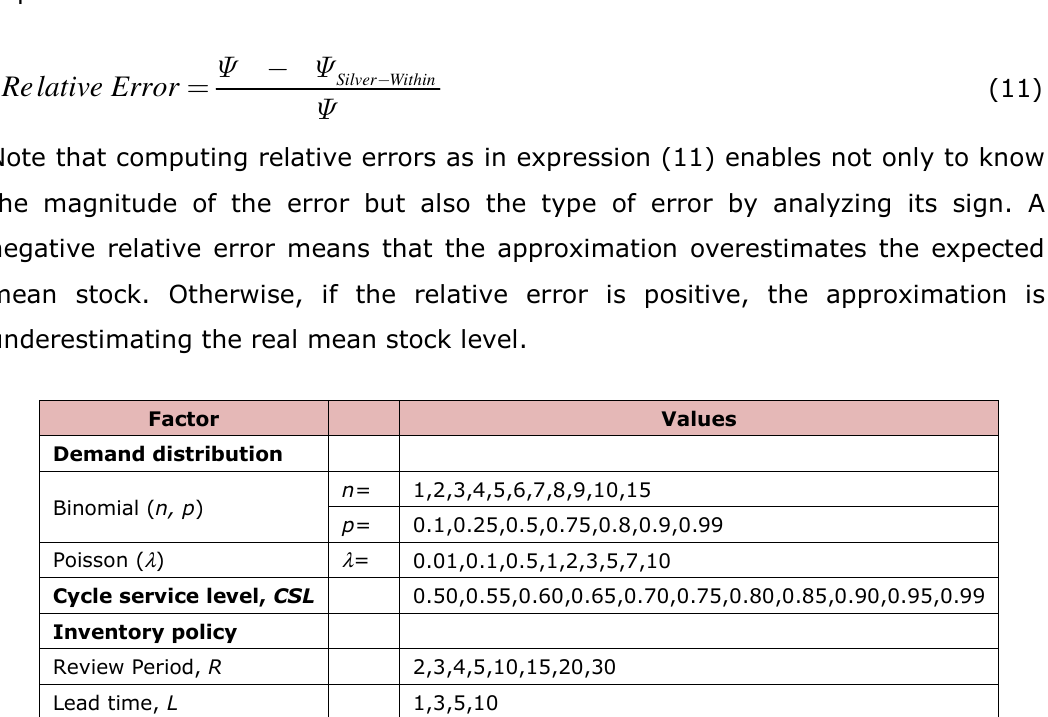
Table 1. “Experiment factors and